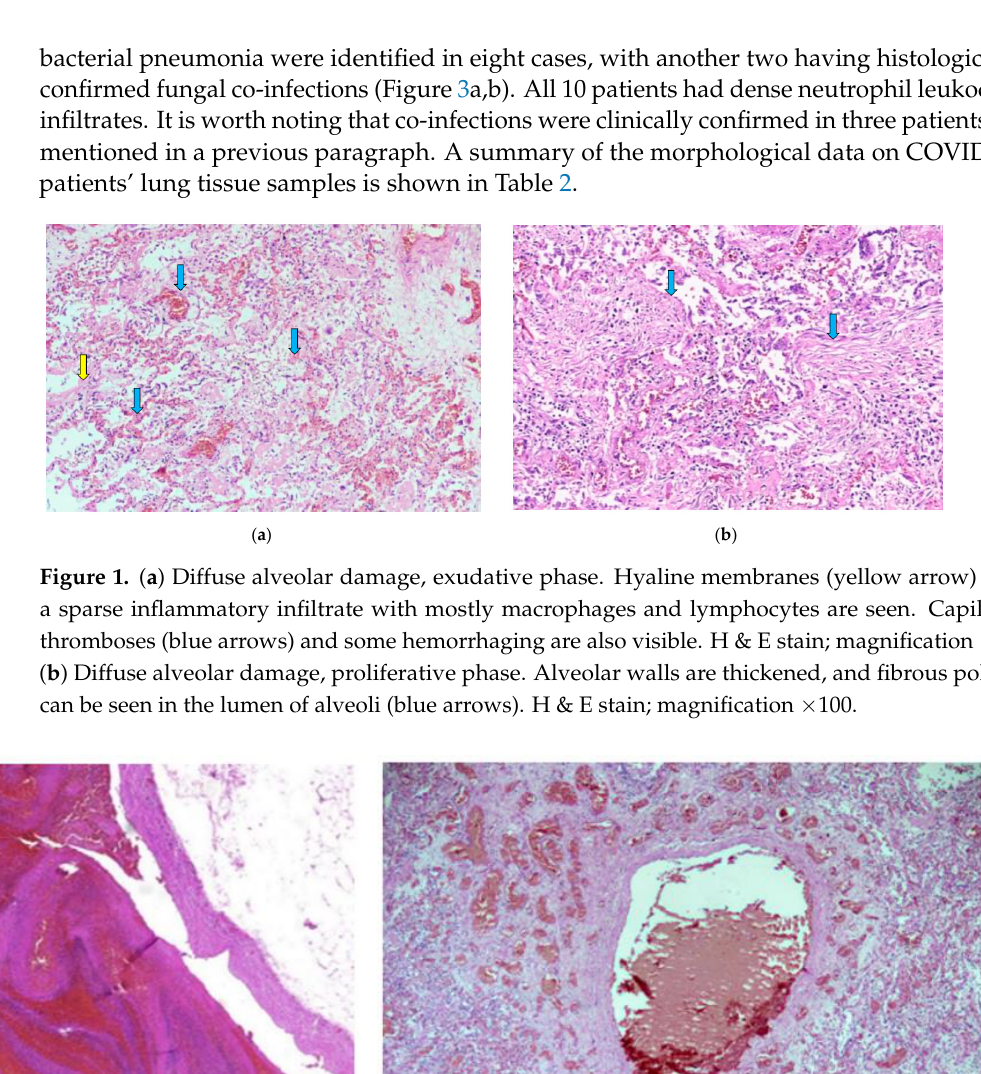
Figure 2. ( a ) Pulmonary thrombosis. An elongated thrombus filling almost the entire lumen of an artery can be seen. H & E stain; magnification ×30. ( b ) Thrombus in a large vessel with smaller vessel thromboses surrounding it. H & E stain; magnification ×40.